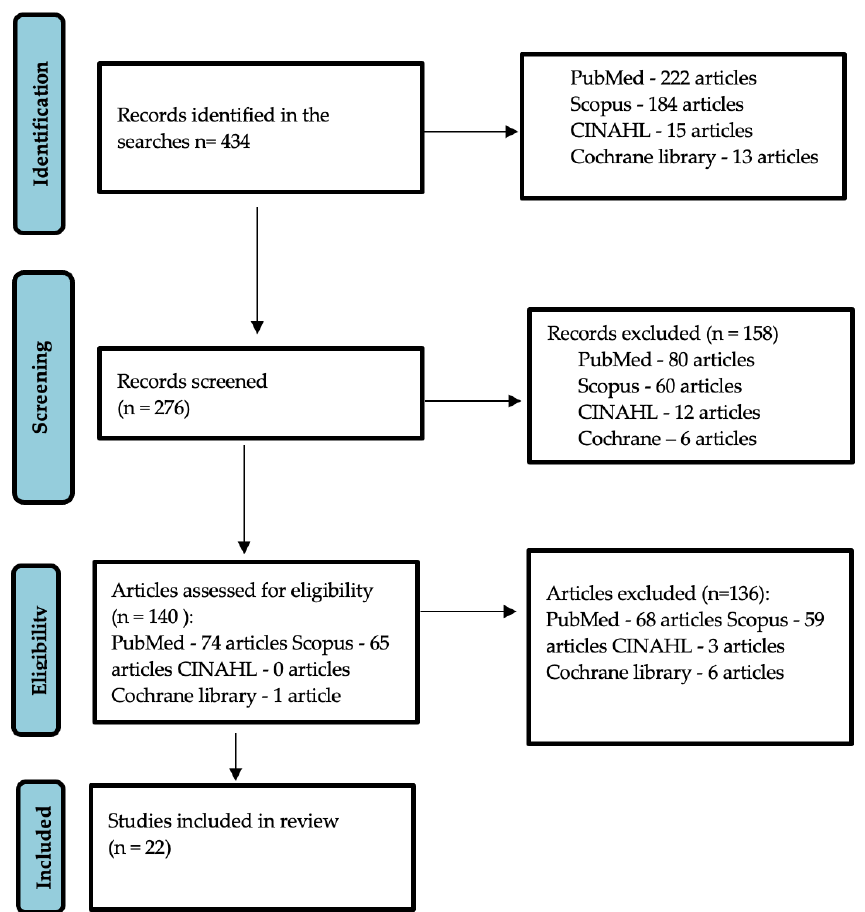
Figure 1. Flow chart (PRISMA guidelines).